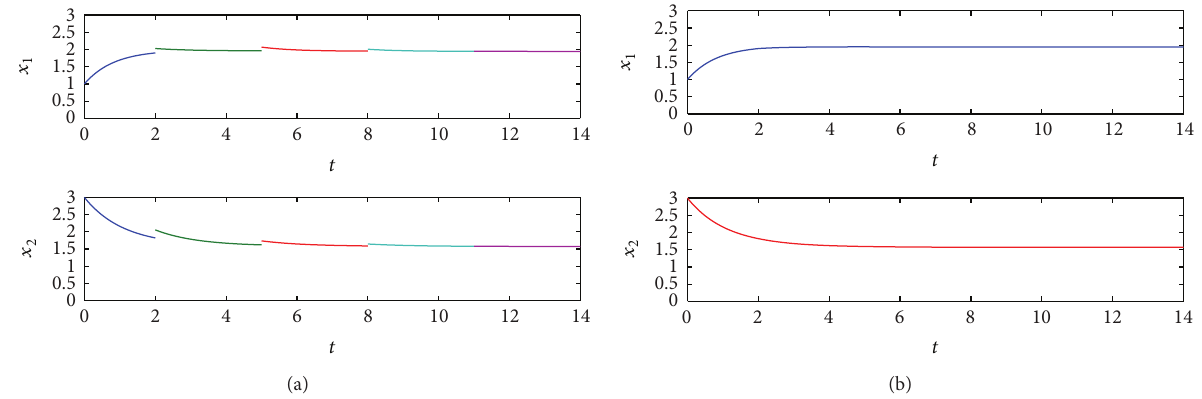
Figure 1: (a) The simulation, where the initial value is chosen as (1,3) 𝑇 , illustrates that all trajectories uniformly converge to the unique equilibrium 𝑥 ∗ = (1.943, 1.57) 𝑇 for the ICNNs (57) with impulsive effects. (b) The simulation, where the initial value is chosen as (1,3) 𝑇 , illustrates that all trajectories uniformly converge to the unique equilibrium 𝑥 ∗ = (1.943, 1.57) 𝑇 for the ICNNs (57) without impulsive